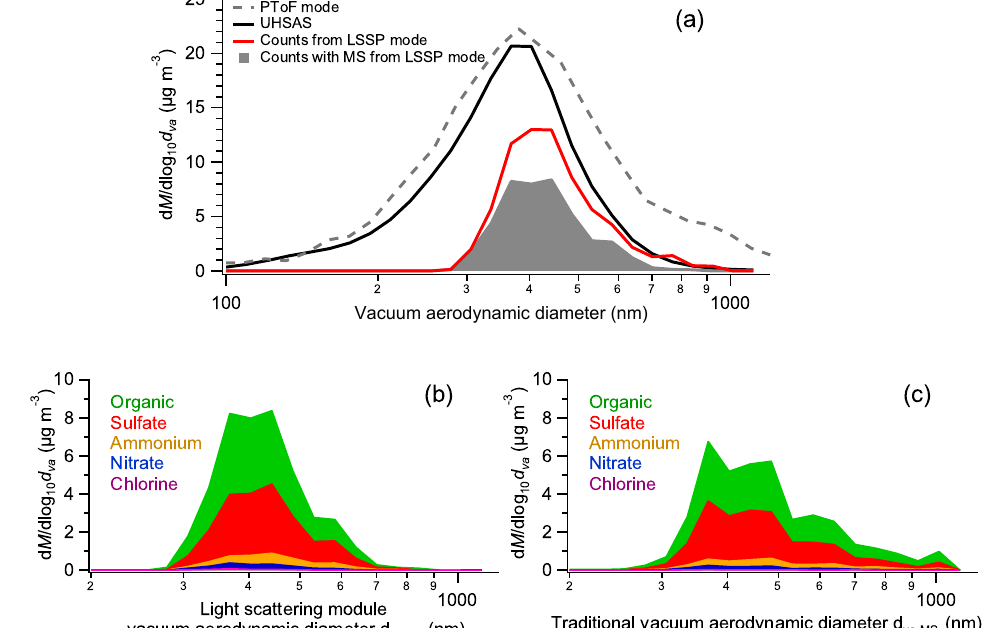
Figure 8. Size-dependent mass distributions as a function of vacuum aerodynamic diameter from low altitudes during the flight on 6 July 2013. (a) The mass is determined from the traditional AMS PToF mode vs. d va-MS (dashed), from the UHSAS instrument vs. d va (black) from Eq. (1) after correcting the particle number distribution for the AMS lens transmission and using an estimated density of 1.55gcm − 3 , from the AMS LSSP internal particle counts vs. d va-LS (red) also using an estimated density of 1.55gcm − 3 , and from the AMS LSSP counts with mass spectra (MS) vs. d va-LS (gray area). Panels (b) and (c) highlight the differences between plotting the mass distributions for each species measured using AMS LSSP mass spectra as a function of either (b) the light-scattering module derived vacuum aerodynamic diameter ( d va-LS ) or (c) the traditional vacuum aerodynamic diameter ( d va-MS ). All particles that scatter light and have mass spectra (including the delayed ones) are included in the d va-LS and d va-MS distributions (b, c) . The difference between these two distributions arises because the size from light scattering ( d va-LS ) is more representative of the particle sizes, whereas d va-MS is influenced by particles that are